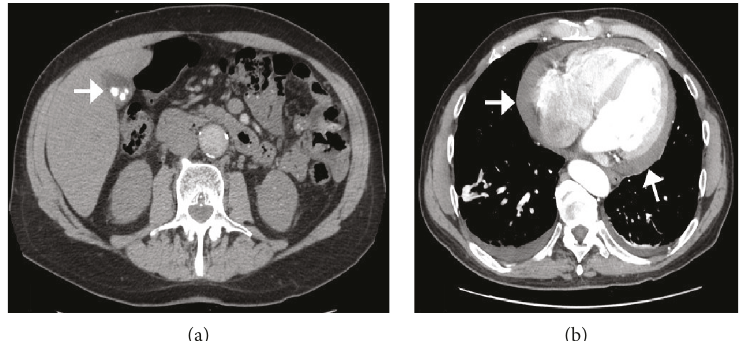
Figure 1: CT scan of the abdomen. (a) Showing gallstones (arrow) with questionable gallbladder wall thickening or pericholecystic fl uid. (b) Moderate amount of fl uid in the pericardial space appears to be of increased density compared to simple fl uid, suggestive of hemorrhage (arrow).